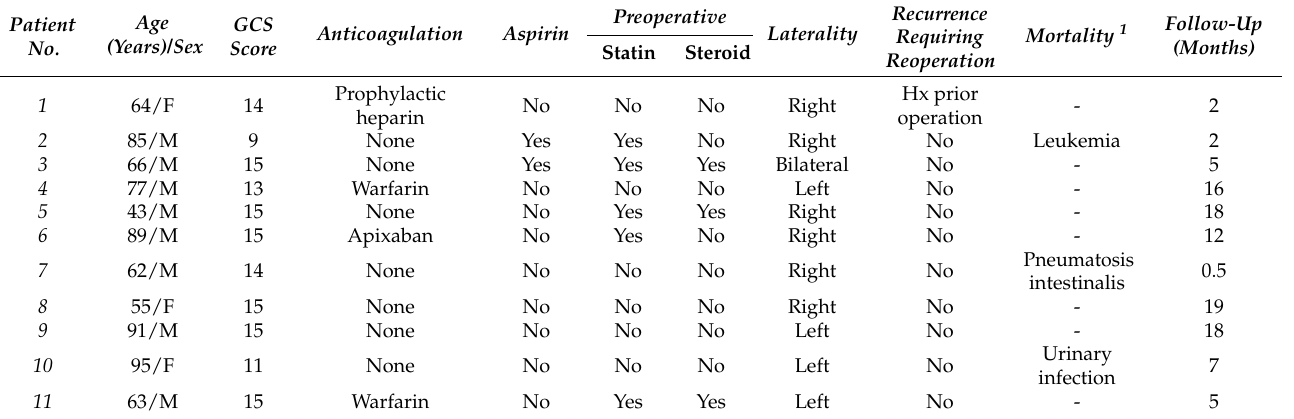
Table 1. Demographic and clinical information for 11 of the 26 patients enrolled.